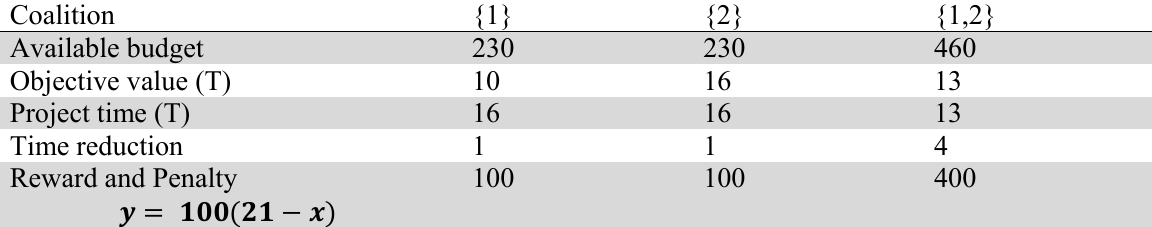
Value of characteristic function for coalitions with two subcontractors